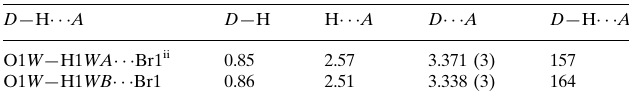
Hydrogen-bond geometry (A˚ , (cid:2)